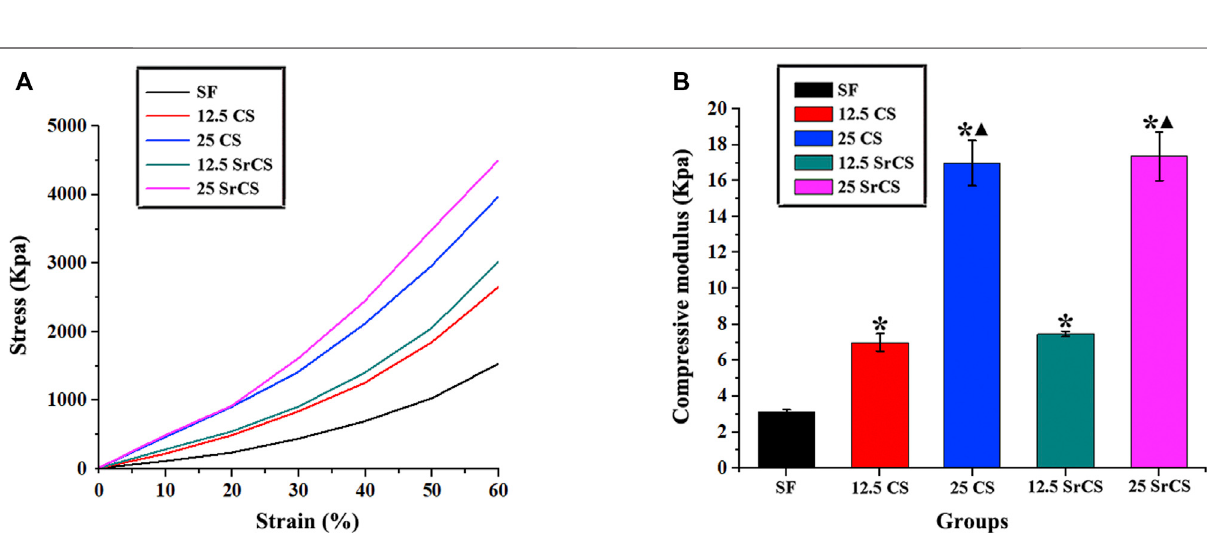
Frontiers in Bioengineering and Biotechnology |